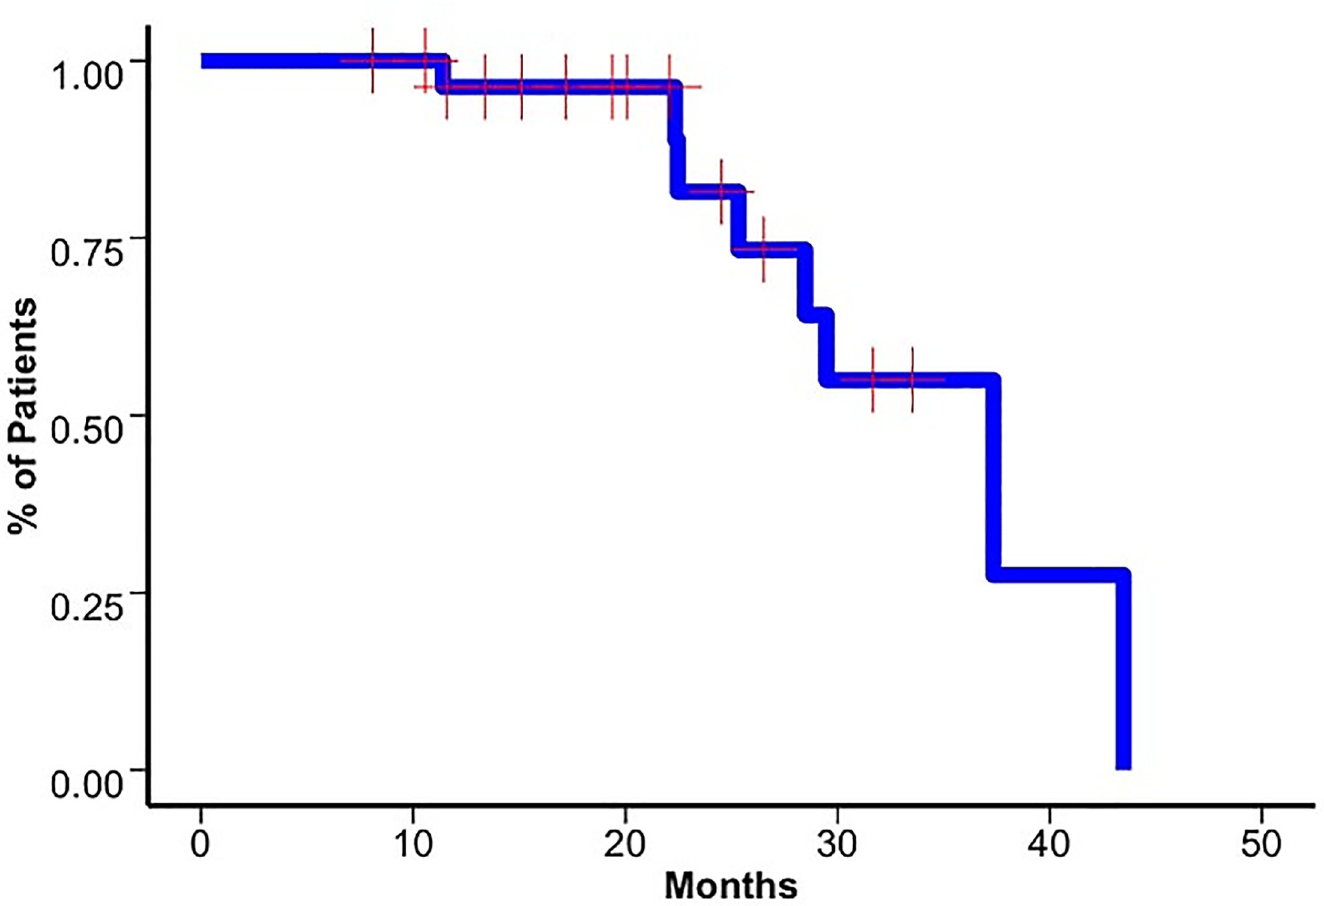
Fig 1. Overall survival for entire cohort. Kaplan–Meier curve for overall survival (OS) for the entire study cohort after medical treatment initiation (37.3 months, 95% CI 28.5–42.1).